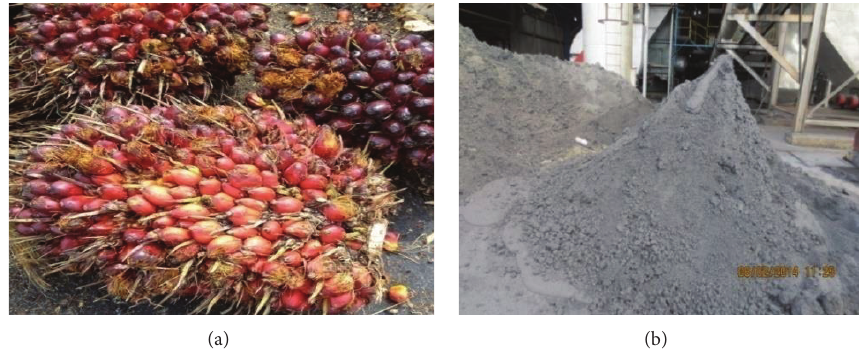
Figure 4: Palm fruits (left) and raw palm oil fuel ash